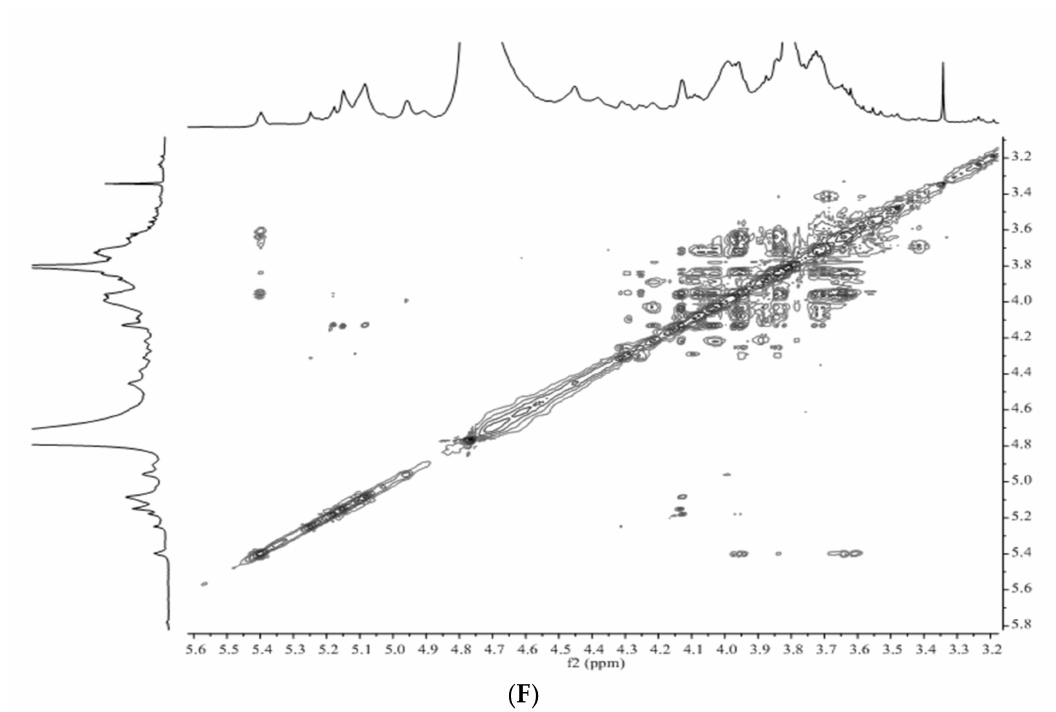
Figure 4. NMR spectra of APS. ( A ), 1H spectra; ( B ), 13C spectra; ( C ), HSQC spectra; ( D ), HMBC spectra; ( E ), HSQC-TOCSY spectra; ( F ), COSY